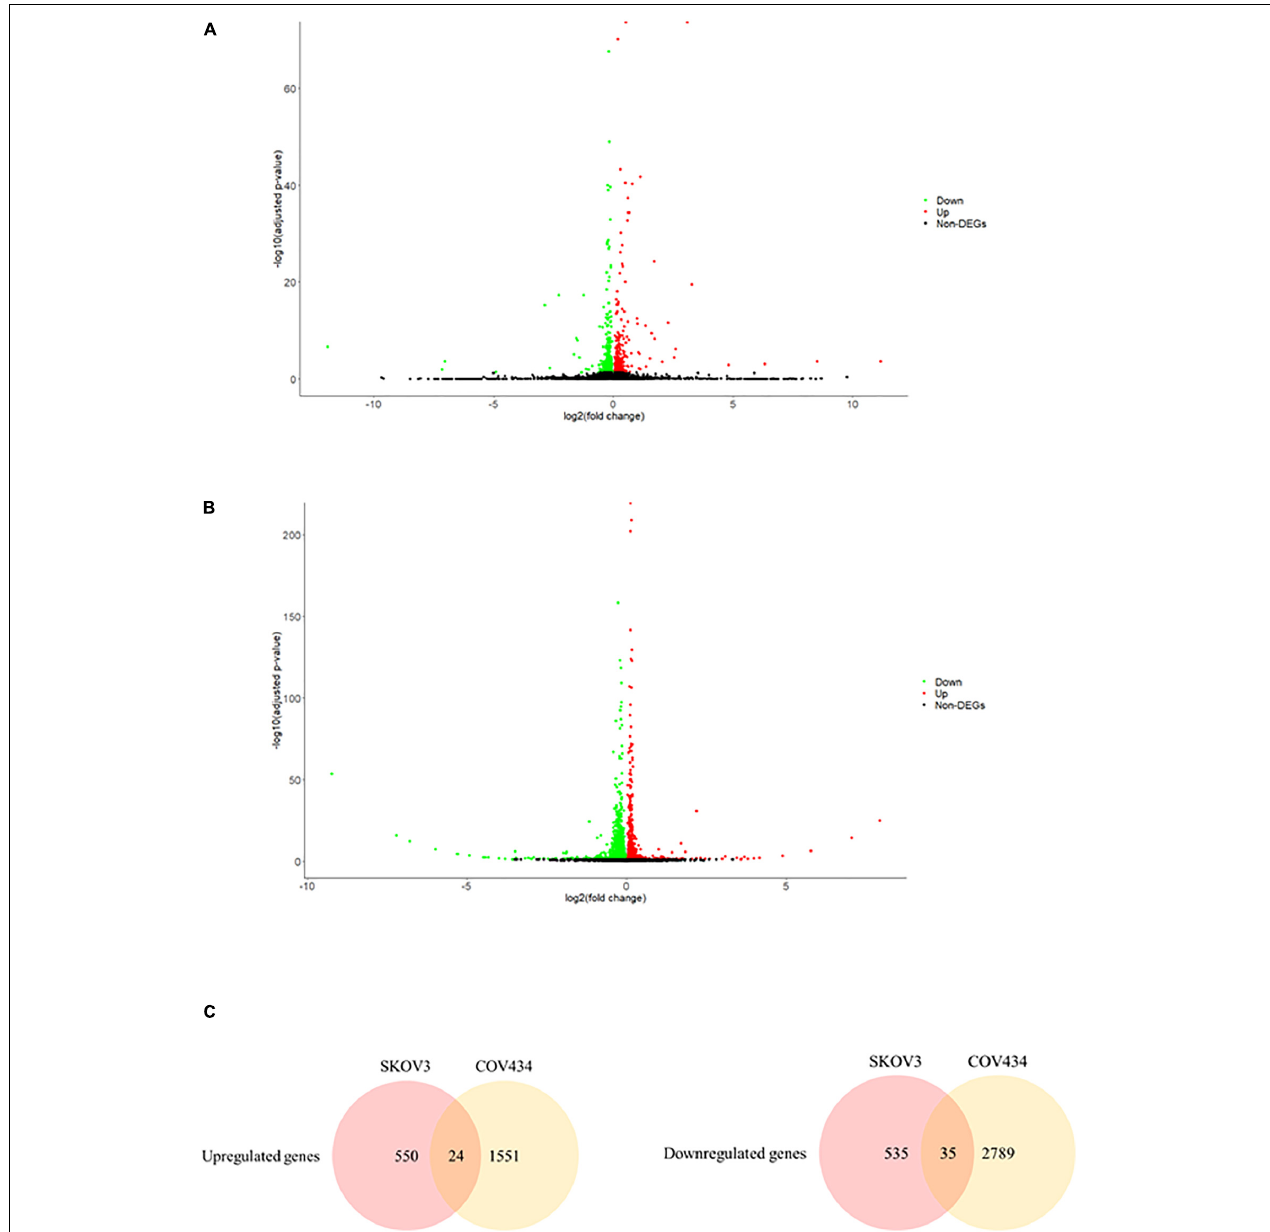
FIGURE 2 | The ionizing radiation exposure caused the differential gene expression in male reproductive cells. (A) Volcano plot showed the differentially expressed genes in the TM4 cells. Green dots represented downregulated genes. Red dots represented upregulated genes. (B) Volcano plot showed the differentially expressed genes in the GC-1 cells. Green dots represented downregulated genes. Red dots represented upregulated genes. (C) Common deregulated genes in TM4 and GC-1 cells under the ionizing radiation exposure.